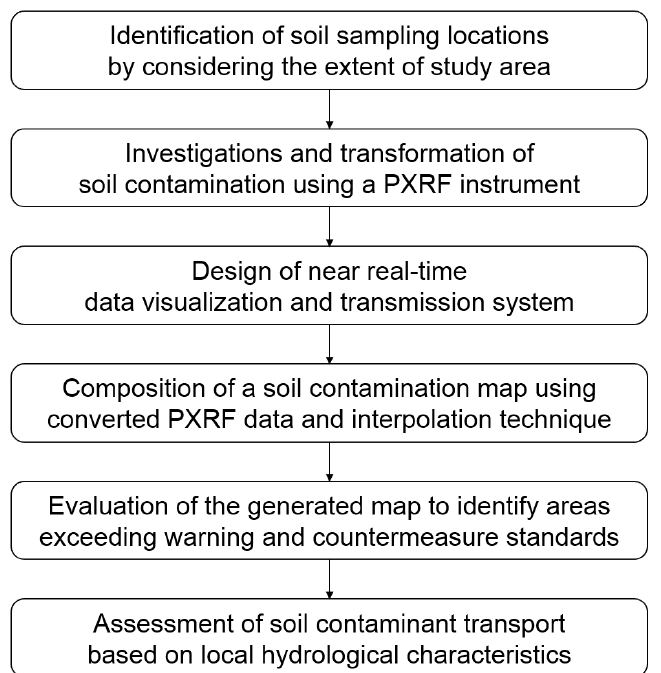
Figure 1. Procedure for the rapid, accurate, and efficient soil contamination mapping method developed in this study.